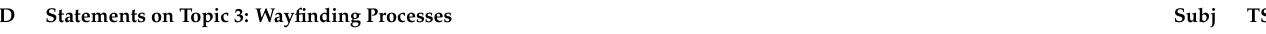
Table A5. Abbreviations used in this table: ID = statement identifier; Subj = subjects; TS = Trial Session.